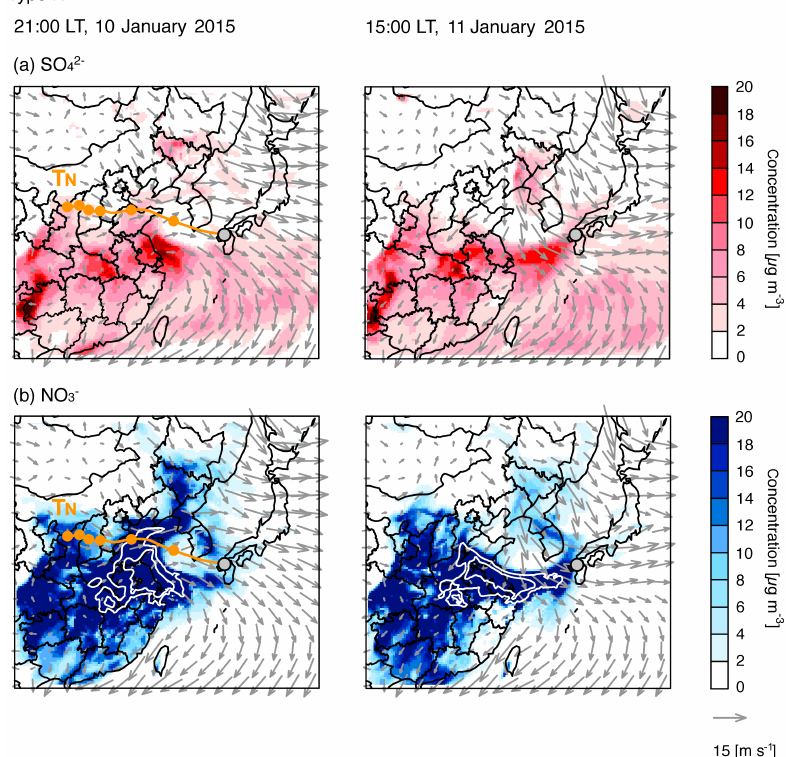
Figure 9. The simulated spatial distribution of (a) SO 2 − NO − represent 40 and 60µgm − 3 . The 72h HYSPLIT backward trajectory from Fukuoka is overlaid with orange lines and orange circles at 3 12h intervals. (Left) 21:00LT on 10 January 2015 when the air mass left China and (right) 15:00 LT on 11 January 2015 when the air mass reached